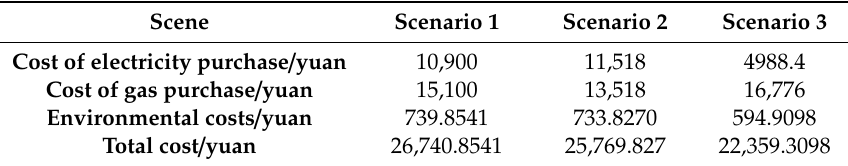
Table 4. Comparison of operating costs in di ff erent scenarios.